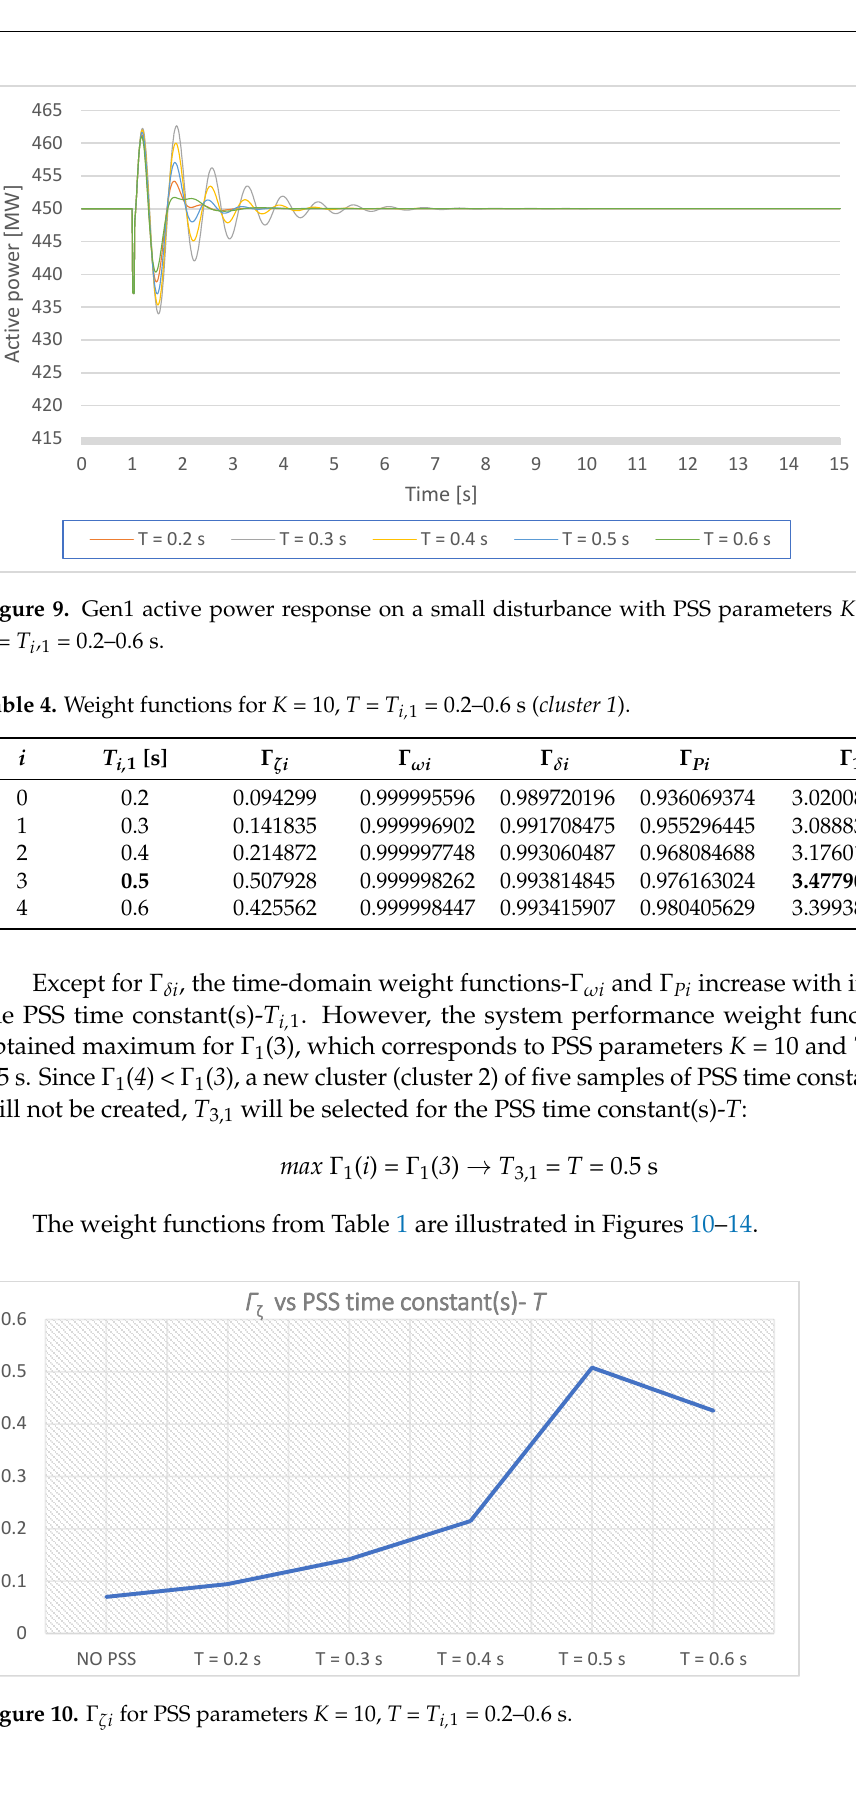
Figure 11. Γωi for PSS parameters K = 10, T = Ti, 1 = 0.2 – 0.6 s. Figure 12. Γ δi for PSS parameters K = 10, T = Ti, 1 = 0.2 – 0.6 s.